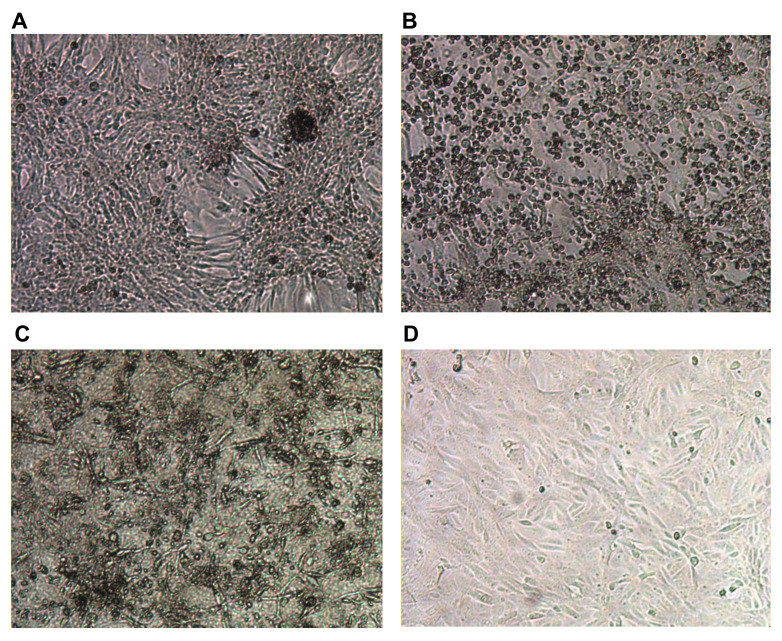
Typical images from cell culture in an
in vitro system for SARS-CoV-2 culture.Top row shows controls: (
A) Negative control Vero E6 cells in media; (
B) Cytopathic effect (CPE) in Vero E6 cells spiked with Victoria/01/2020 SARS-CoV-2; Bottom row shows Vero E6 cells inoculated with 1/10 dilution of serum sample from sample VC12 (patient ID UKCOV040), that tested positive for SARS-CoV-2 RNA by RT-PCR; (
C) Aberrant cellular effects at day 4 in a culture inoculated with VC12 at day 0; (
D) Normal appearance of cells at day 7 inoculated with 1/10 dilution of the culture supernatant of the VC12-challenged culture, illustrated in (
C). Raw unedited microscope images can be accessed individually on line
9.